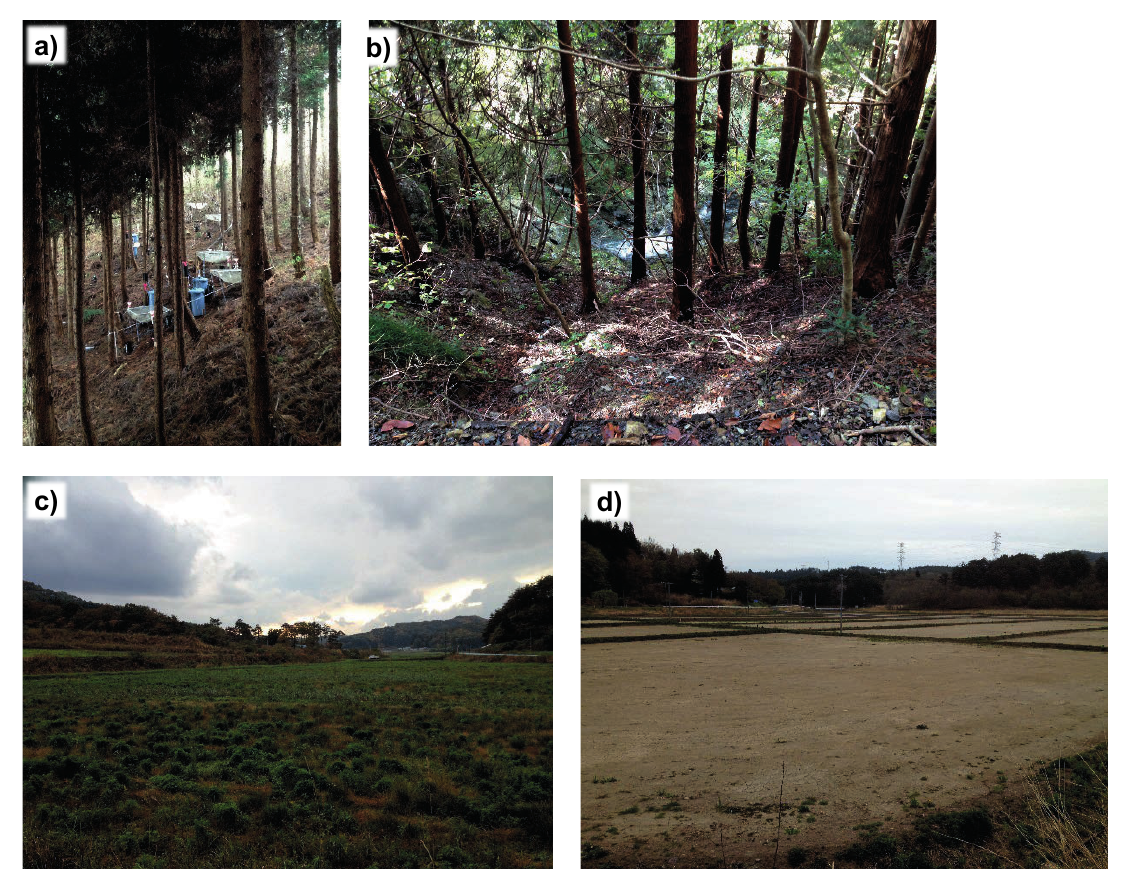
Fig. 4 (a) Evergreen forest with thick and dense litter cover of the soil (as observed in upper parts of the Mano catchment), (b) broadleaf forest on steep slopes within the Ota catchment, (c) abandoned paddy field in Mano catchment, and (d) decontaminated paddy field in the Nitta